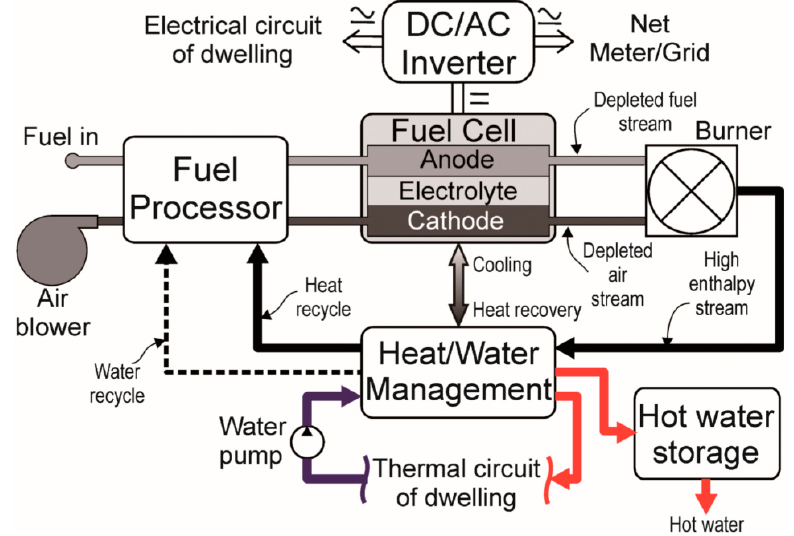
Figure 5. The schematic diagram for fuel cell micro CHP systems [94].